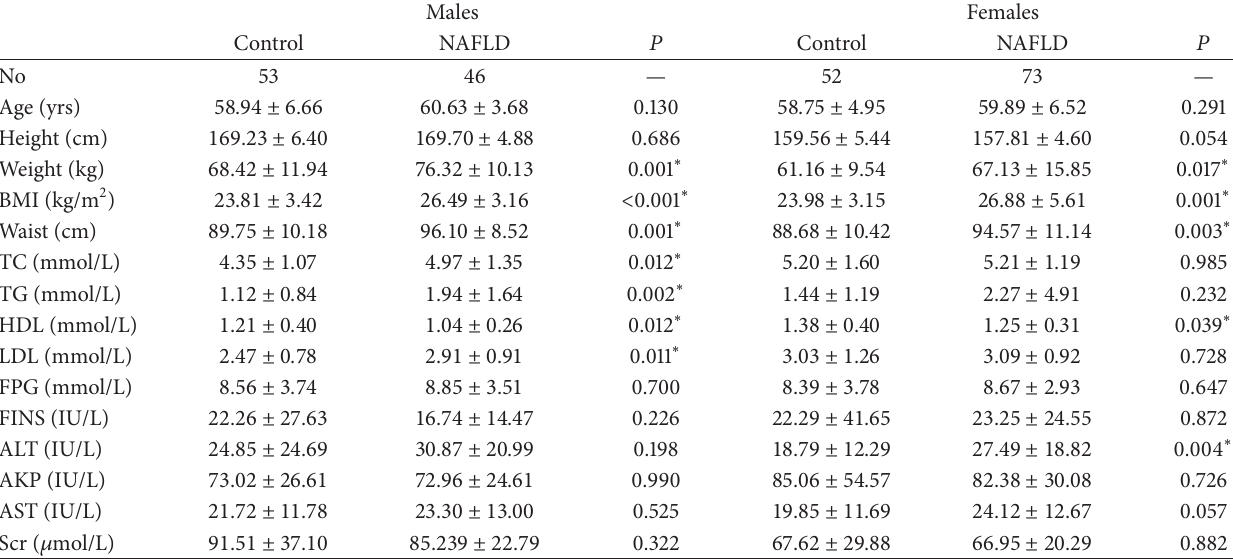
Table 1: Patients’ characteristics at baseline.